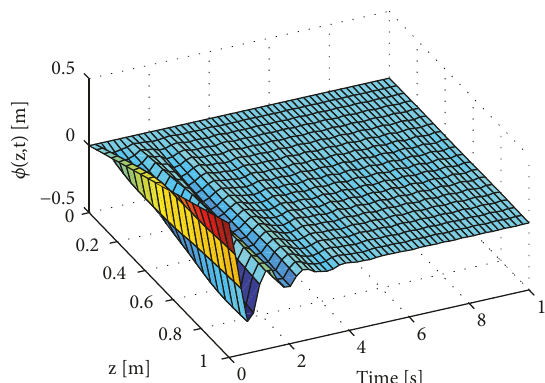
Figure 5: Rotation of the flexile link with proposed control.